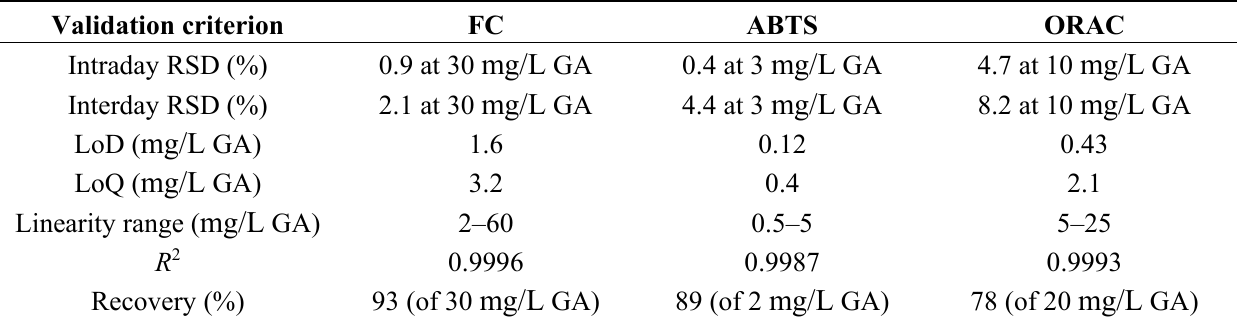
Table 2. Validation of analytical results for the FC, ABTS and ORAC